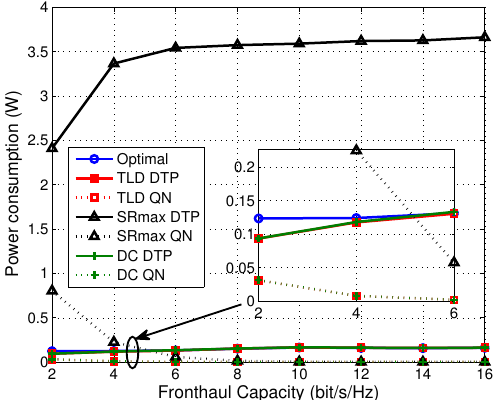
Figure 5. Average power consumption at various fronthaul capacities.